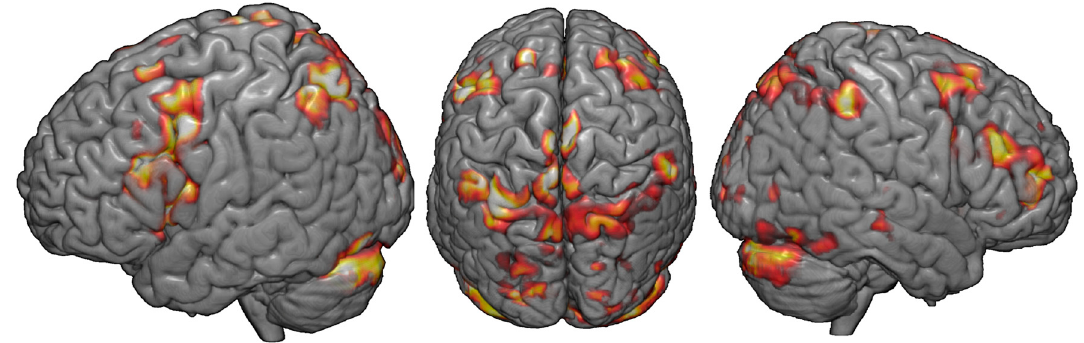
Figure 4. fMRI response to the DRAT task: Whole-brain results describing the parametric increase in BOLD-related activity with increasing task difficulty (2< z <3).